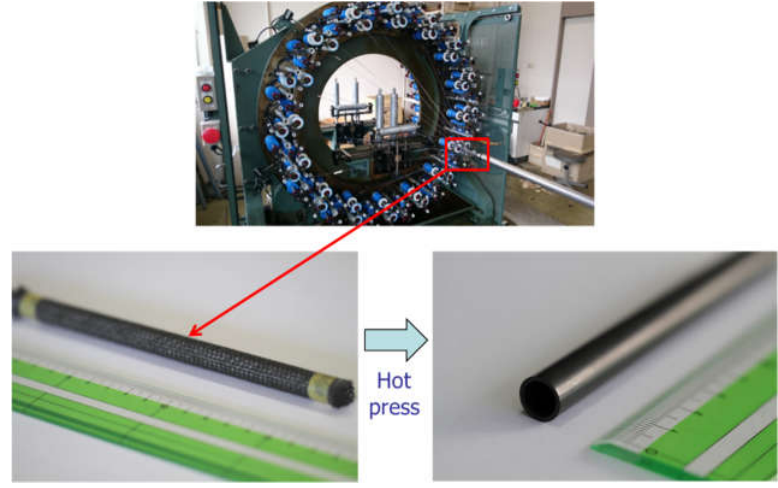
Figure 10. The LPS SiC composite tube fabrication utilizing the braiding technique.